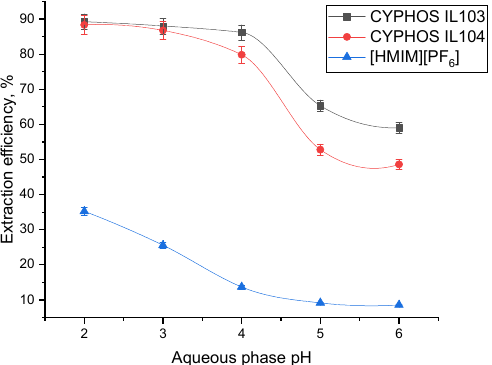
Figure 4. Aqueous phase pH influence on extraction efficiency (ionic liquid concentration 40 g/L).